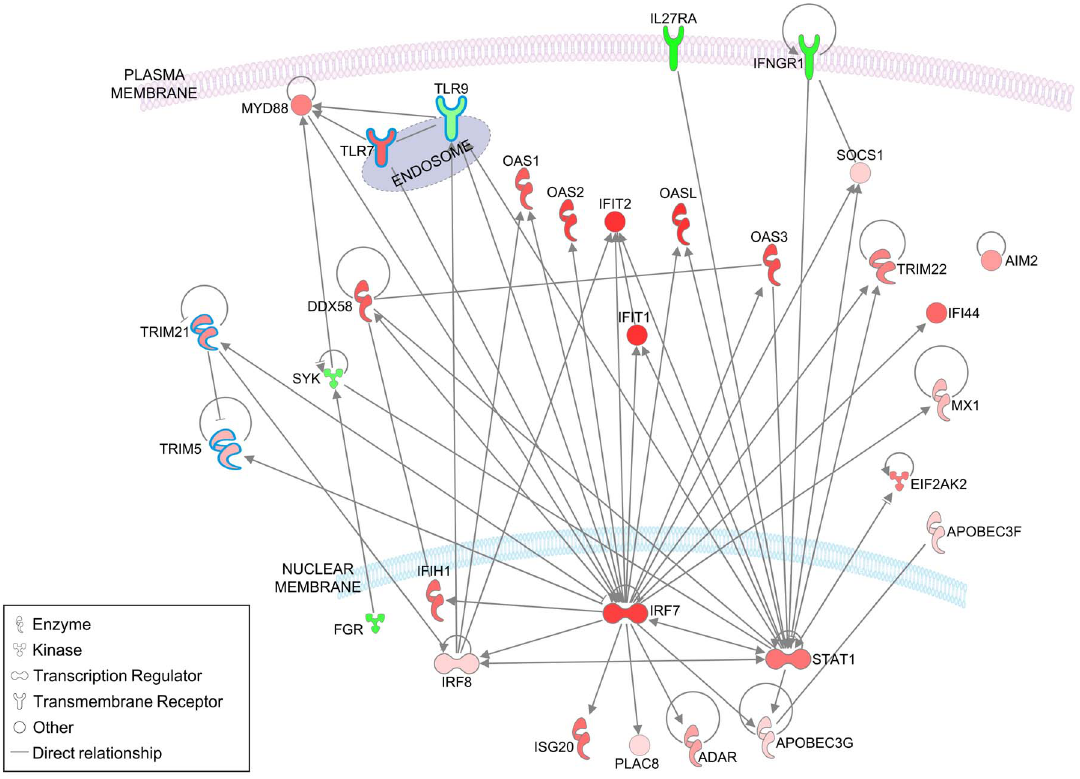
Figure 6. IFN- b activates the antimicrobial pathway and related innate immunity genes in LCLs. The pathway depicted includes the 27 genes of the of the ’antimicrobial response’ pathway that showed increased activation following IFN- b exposure of LCLs (activation score Z=2.779) by Ingenuity analysis. In addition, genes outlined in blue were manually added to the pathway based on their known participation in the innate response in B cells or other leukocytes, and include TLR7 and TLR9 [20] [74], TRIM21 and TRIM5 [75–77]. Only direct connections are featured, and subcellular location of gene products is as suggested by Ingenuity knowledge base. In green- down-regulated genes; in red- up-regulated genes, color intensity is proportional to the fold change in expression levels following IFN- b exposure.